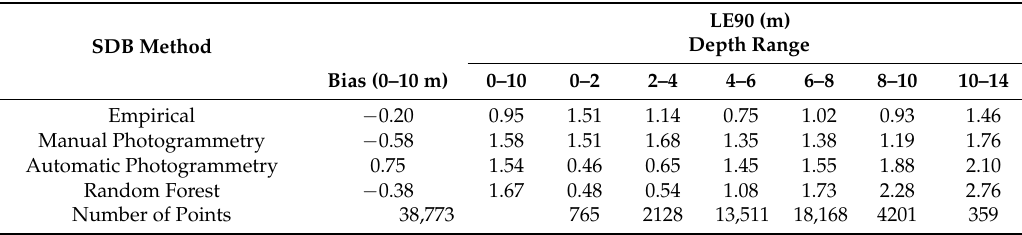
Table 3. Accuracy assessment results for individual SDB techniques.